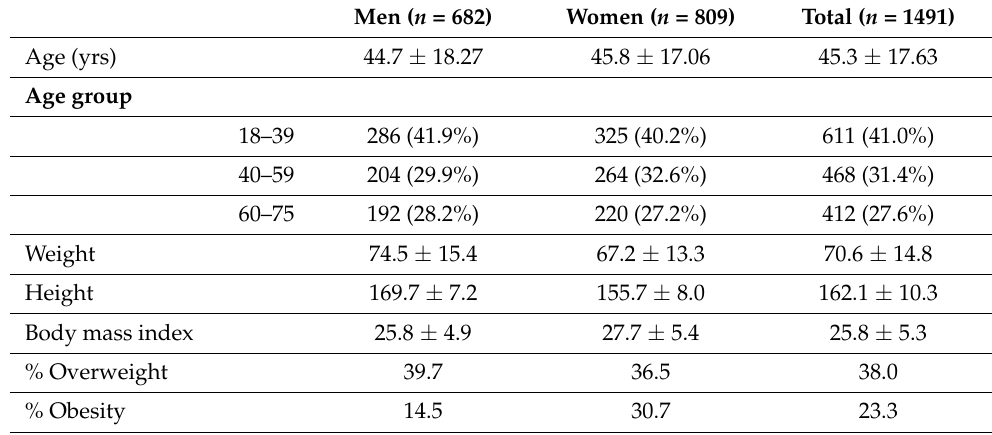
Table 1. Characteristics of the study